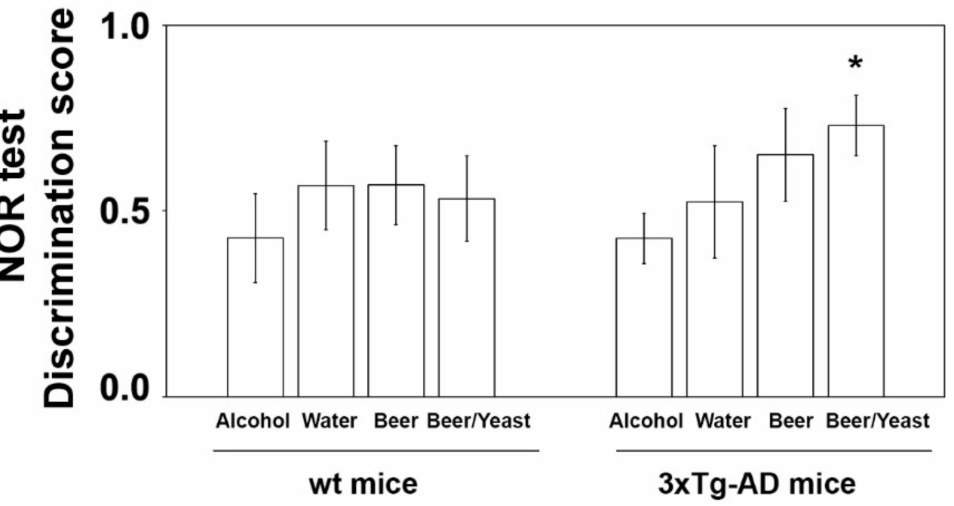
Figure 1. Effect of treatment on the NOR discrimination index in wt and 3xTg-AD mice. Treatment with alcohol, beer or beer/yeast did not affect discrimination index in wt mice, whereas yeast enriched beer (beer/yeast) significantly increased the NOR discrimination index in 3xTg-AD mice. Statistical significance: * p < 0.05 vs. water